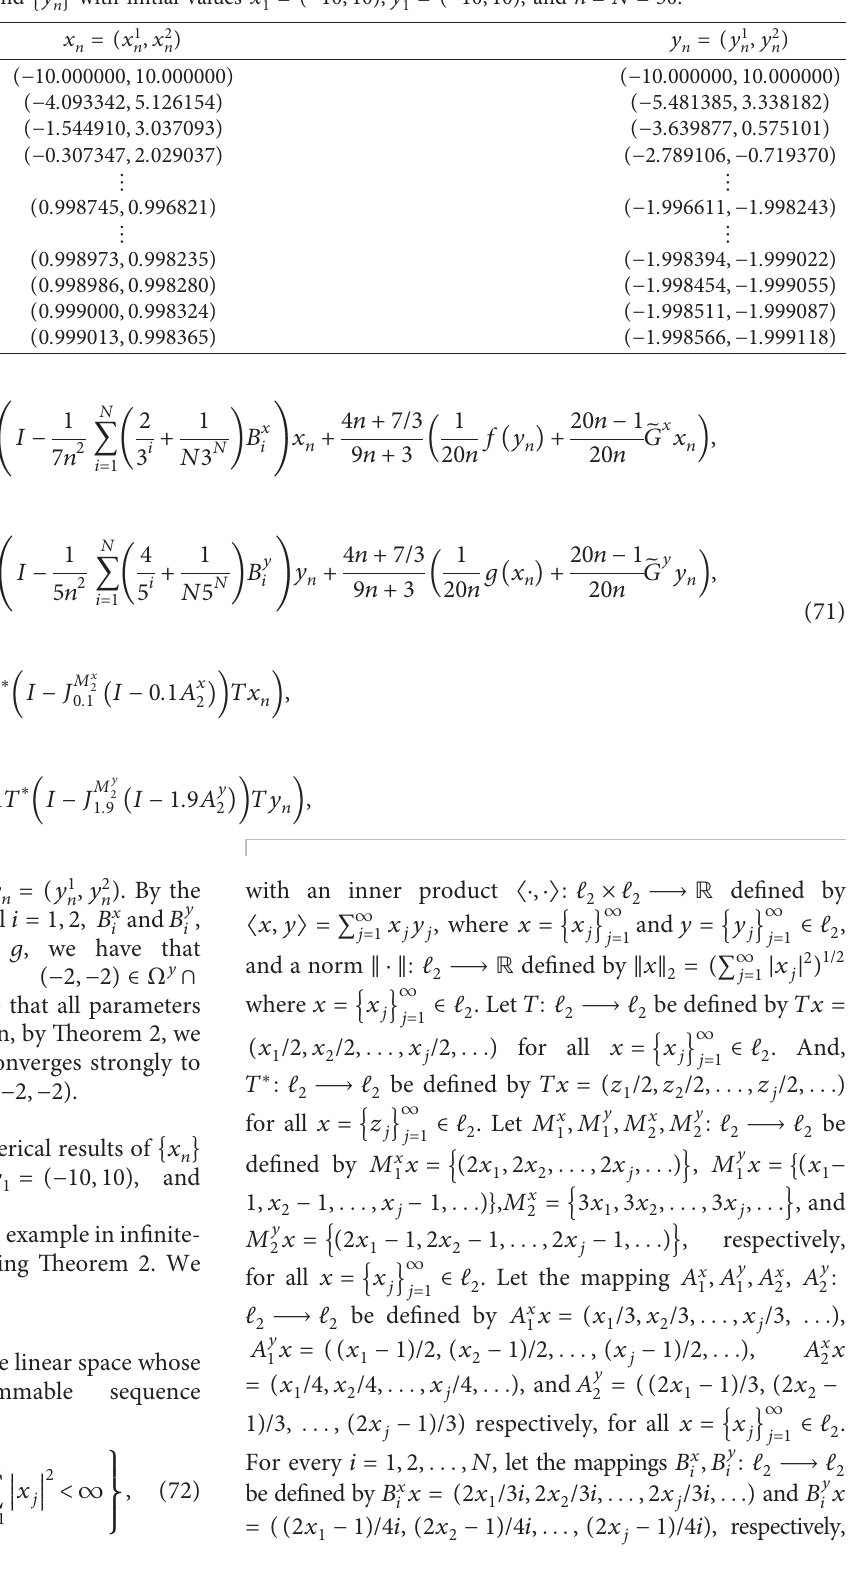
Table 1: Values of x